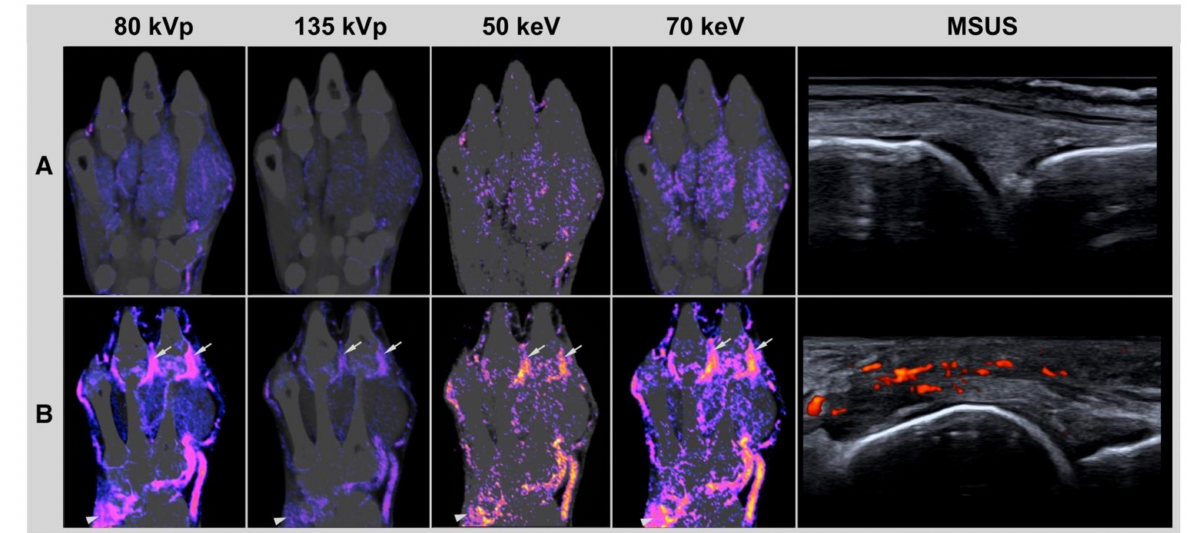
Figure 3. Imaging examples. Conventional CT subtraction for 80 and 135 kVp. Virtual monochromatic imaging CT subtraction for 70 and 50 keV. MSUS: musculoskeletal ultrasound of the metacarpopha- langeal (MCP) joint II from the dorsal view. ( A ) Imaging examples of a 51-years old patient with seropositive rheumatoid arthritis. No inflammatory activity was detected. ( B ) Imaging examples of a 62-years old patient with treatment-naïve seronegative rheumatoid arthritis. Severe synovitis was detected at the metacarpophalangeal (MCP) joint III and II (arrows) and wrist (arrowhead). In 135 kVp, the synovitis in these regions was underestimated. MSUS of the MCP II joint showed synovitis and peritendonitis with severe power Doppler activity.